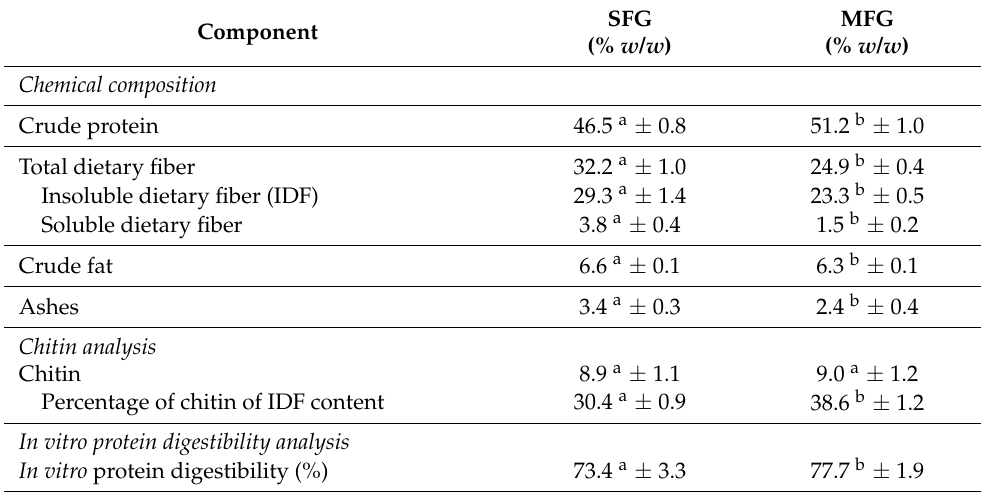
Table 2. Chemical composition, chitin, in vitro protein digestibility, and protein quality indicators of SFG and